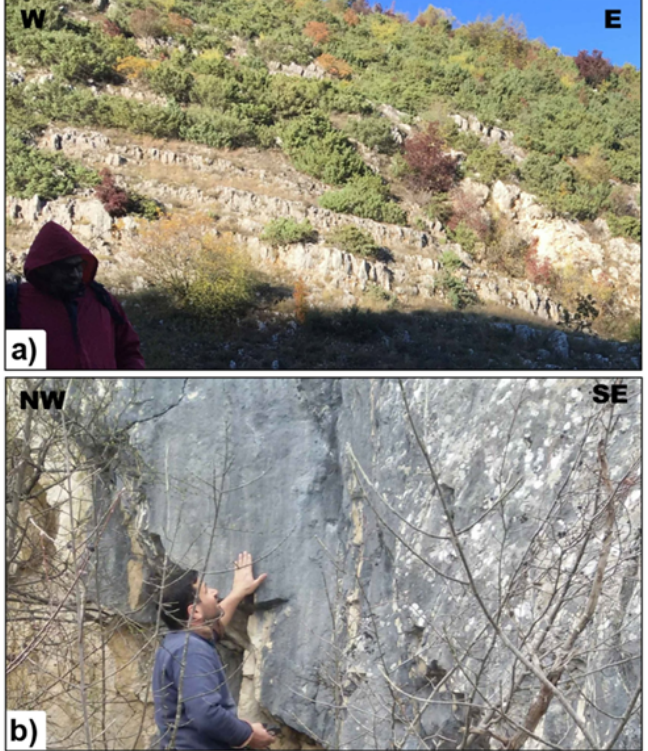
Figure 3. Stratigraphic sequence and main tectonic elements: ( a ) Upper Cretaceous, thinly-layered, biodetritic limestones in the southern sector of the ridge affected by severe jointing; ( b ) left hand resting on a normal fault plane along the eastern edge of the Luco dei Marsi slope (F1 in Figure 2). NNW-SSE-oriented normal faults dissect the entire anticline, whereas later WNW-ESE trending strike-slip faults—mainly with left-lateral kinematics—are concentrated in the southern sectors. The first system marks the eastern boundary of the carbonate ridge and is composed of several faults (F1–F4 in Figure 2 and F1 in Figure 3b) disposed in a cascade-like structure; the vertical down-throw is limited to a few tens of meters along each fault, but the whole system accommodates a cumulative displacement of more than 100